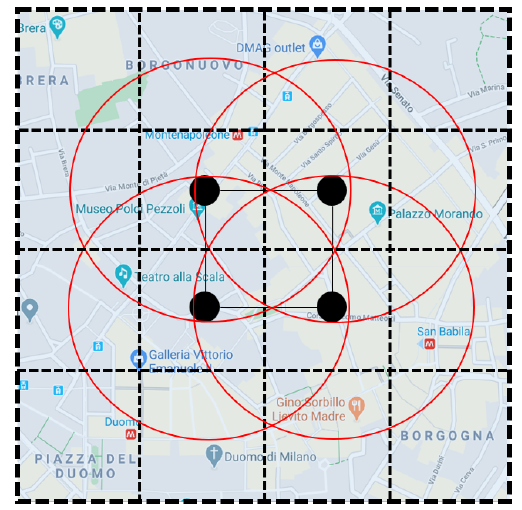
Figure 4. An example of geographical coverage: black points are the drones, thin circles represent their coverage area, and the link represent the connection for data/overhead/LSP